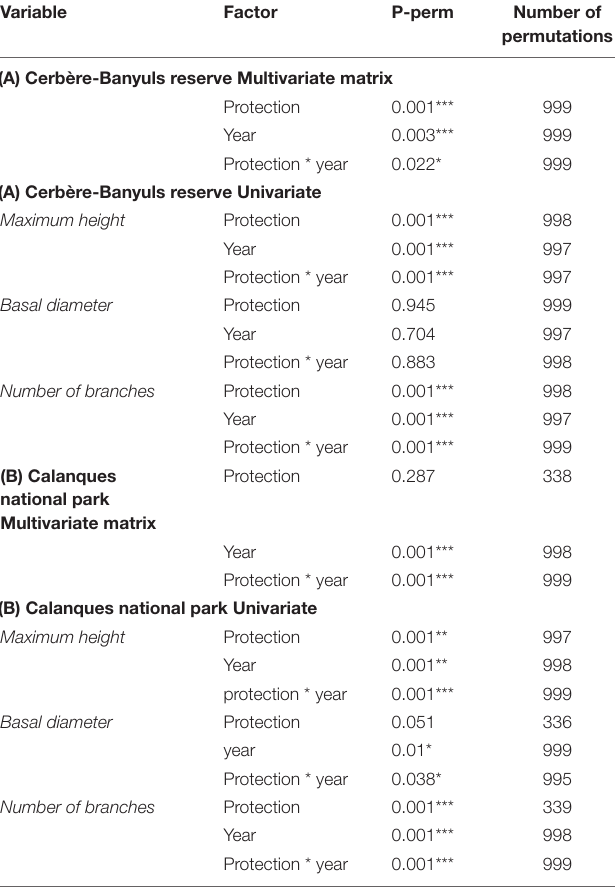
TABLE 4 | Results of permutation analyzes of variance (PERMANOVA) in the Cerbère-Banyuls reserve (A) and the Calanques national park (B) via a design incorporating the year and protection factor (year as a fixed factor with 2 modalities; protection as a fixed factor with three modalities; interaction protection * year) for the multivariate matrix (maximum size; basal diameter; number of branches) and each univariate